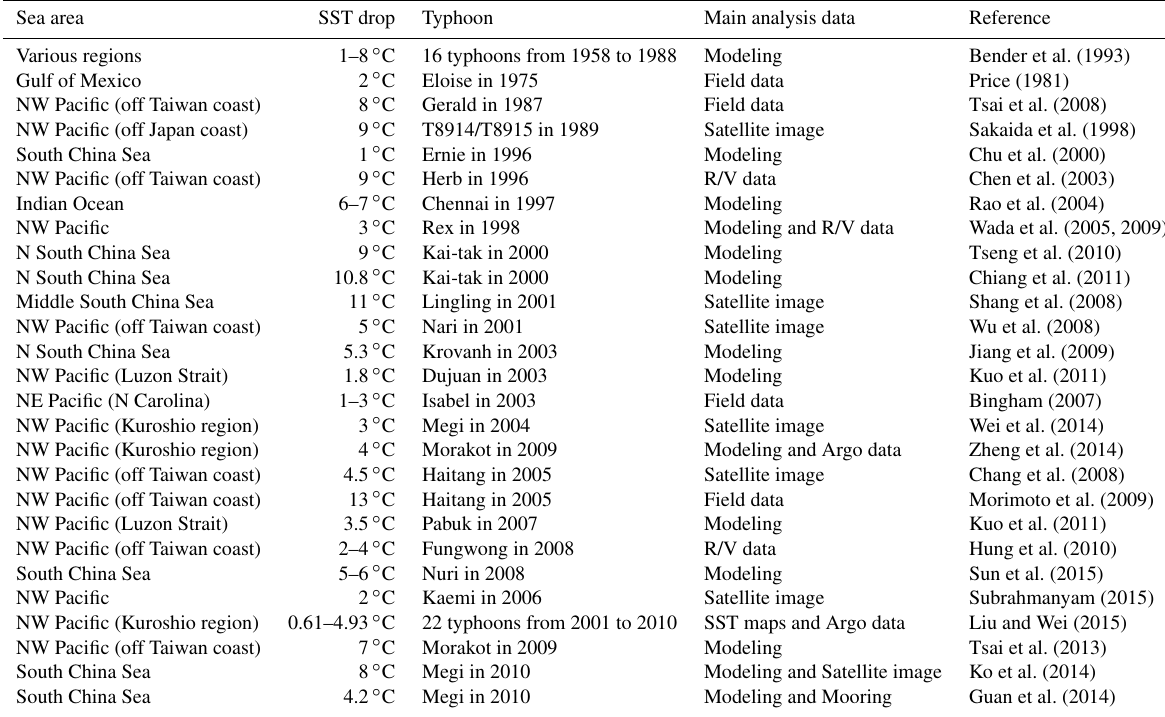
Table 1. Records of the SST drops due to typhoon passages in the literature. Sea area